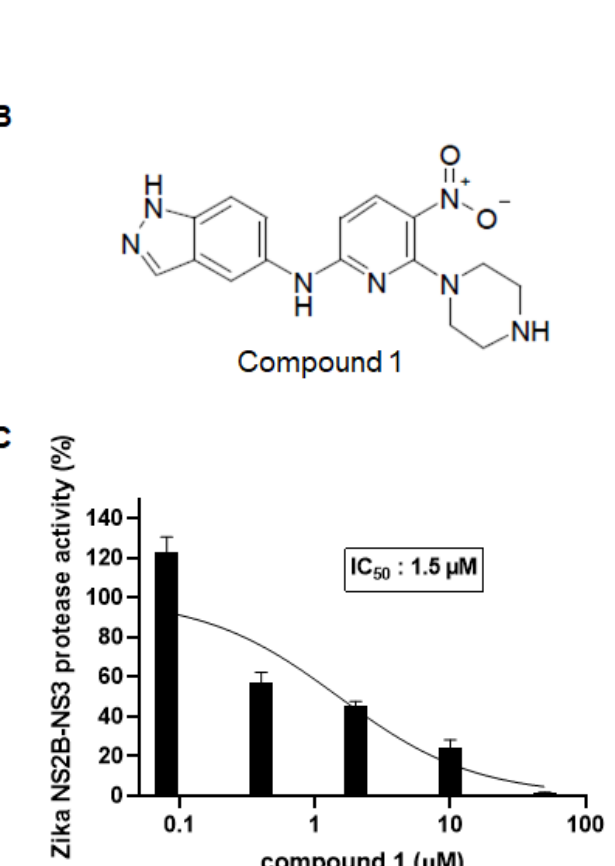
Figure 1. Identification of a novel inhibitor of the Zika virus (ZIKV) NS2B-NS3 protease using structure-based virtual screening and an in vitro protease inhibition assay. ( A ) The ZIKV NS2B-NS3 protease and substrate were mixed with 123 candidate compounds (50 µM) selected from virtual screening. After incubation for 1 h at 37 °C, the fluorescent signal was measured using a plate reader. The protease activity after each treatment was calculated as a relative percentage to the control (DMSO control was set as 100%, no protease control was set as 0%). ( B ) Chemical structure of compound 1. ( C ) The ZIKV NS2B-NS3 protease and substrate were mixed with the indicated concentrations of compound 1, and the fluorescence-based protease inhibition assay was performed. Protease inhibition activity (IC 50 ) was determined from a dose-response curve.